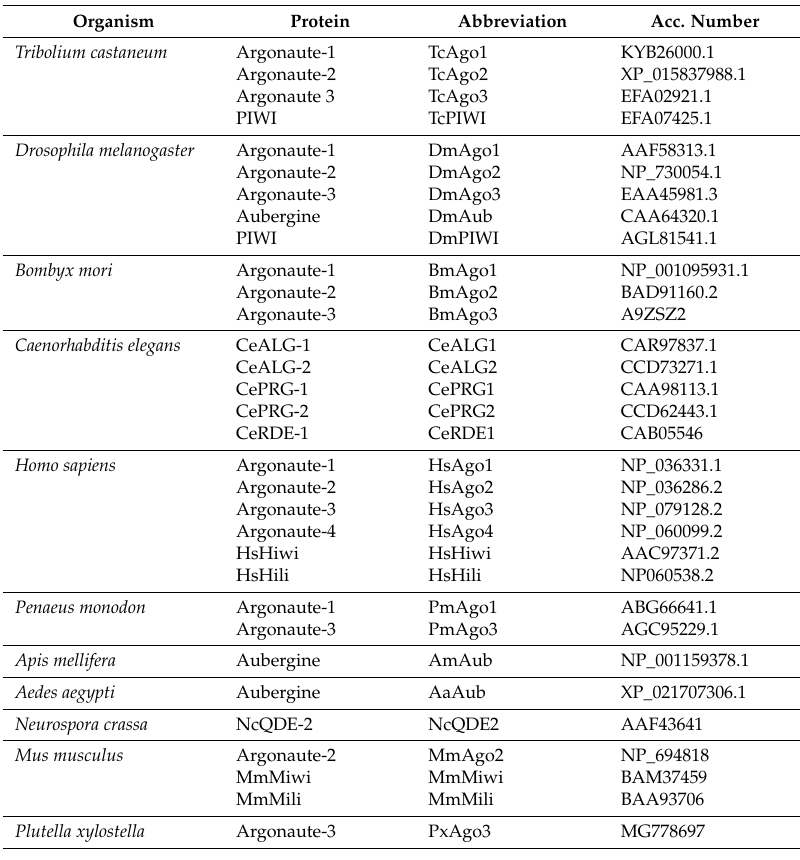
Table 2. Ago proteins with the accession number for multiple-alignment comparison and phylogenetic tree